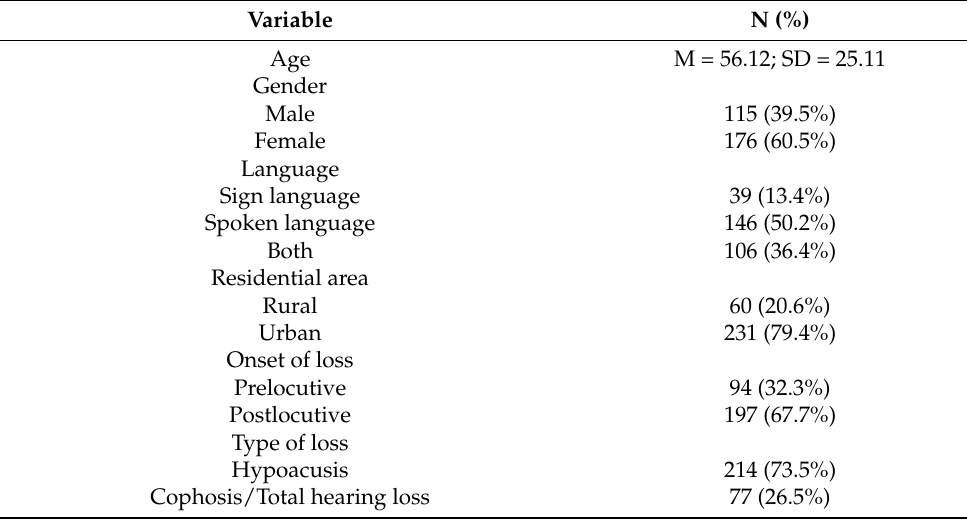
Table 1. Socio-demographic profile of deaf and hard of hearing adults using assistive devices or other technologies for communication (n =